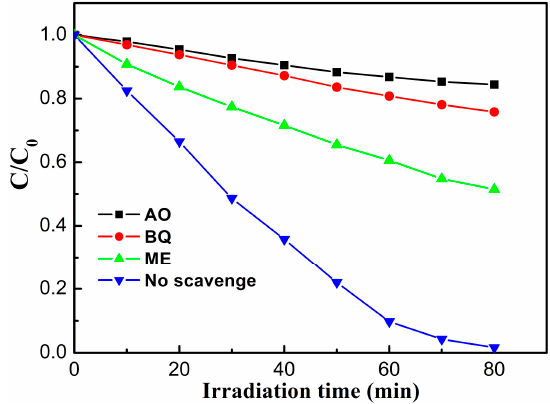
Figure 9. The effects of reactive species involved in the photodegradation of RhB solution over the BS-2# sample.